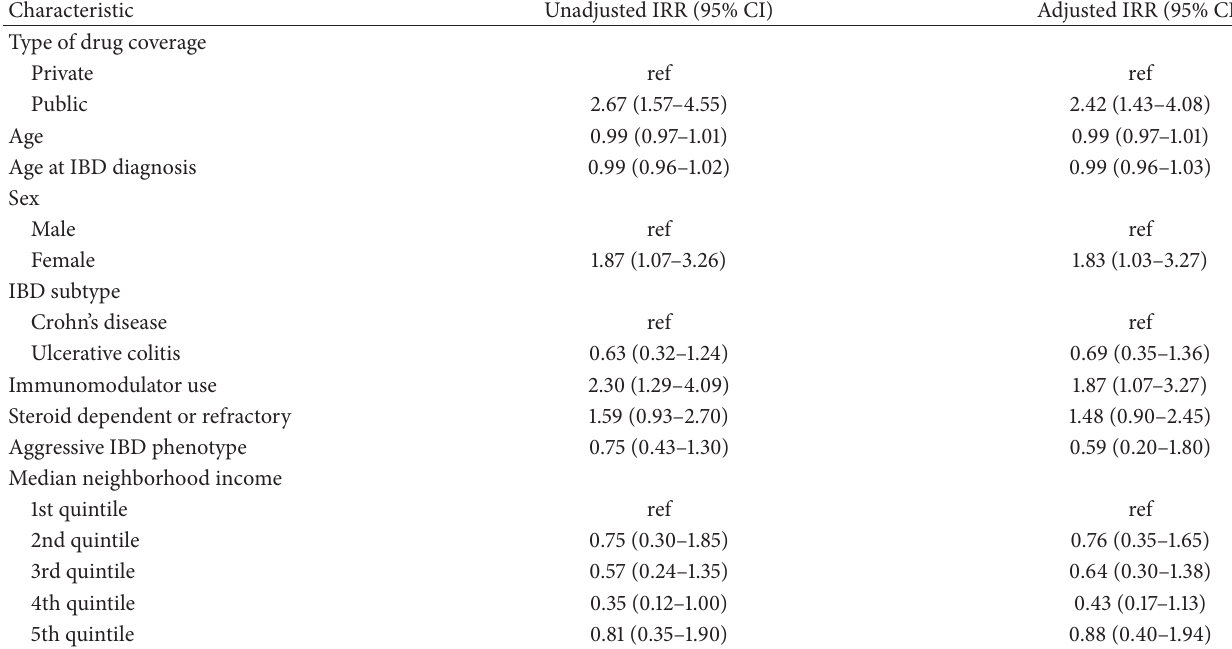
Table 5: Poisson regression model for IBD-related ED